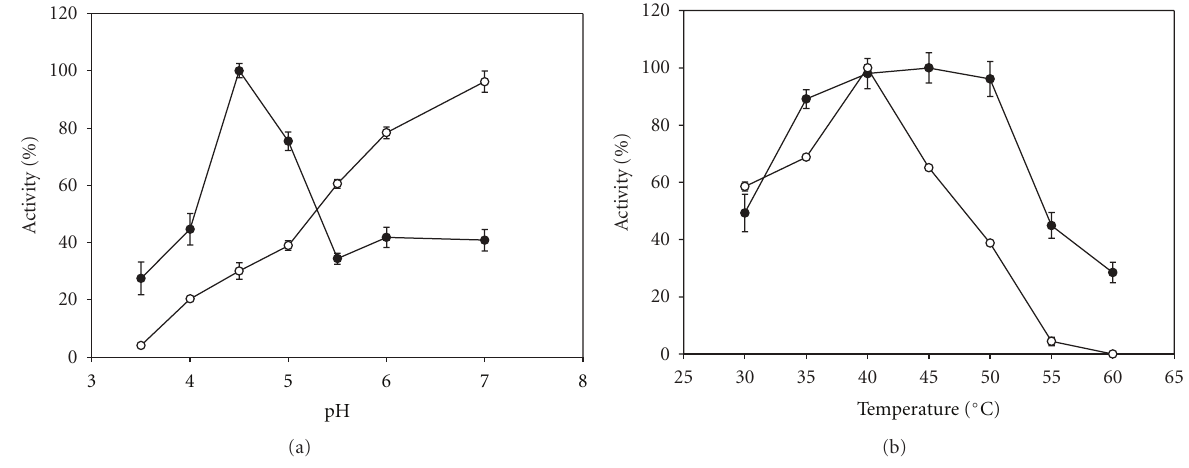
Figure 4: Influence of the pH (a) and temperature (b) on the soluble ( ◦ ) and PVAG-PANIG-HRP ( • ).